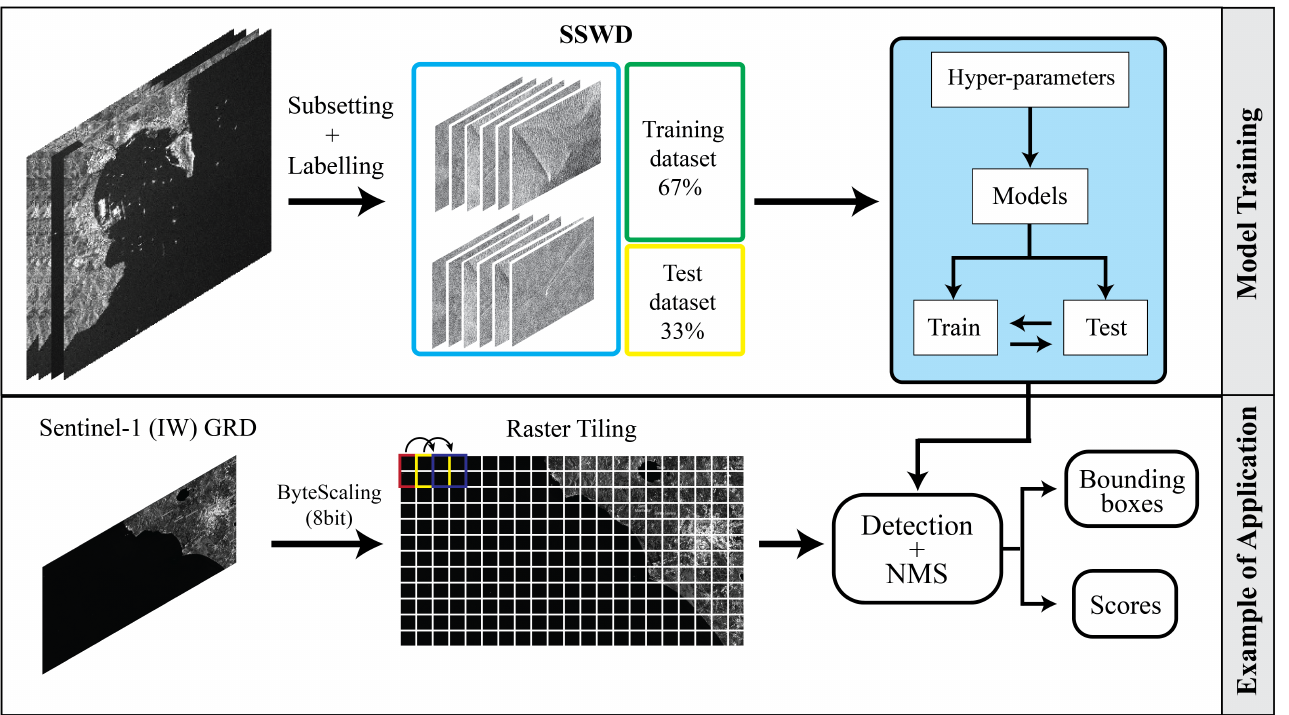
Figure 6. Workflow of the proposed methodology: ( top ) model training and ( bottom ) model performance evaluation on a test scenario in the Gulf of La